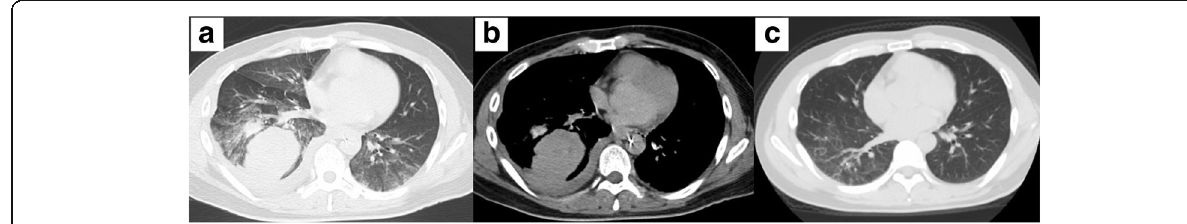
Fig. 2 Chest computed tomographic images revealing right pleural effusion and a large round mass in the right lower lobe ( a , b ). This mass was not observed in a CT examination performed 10 months earlier ( c